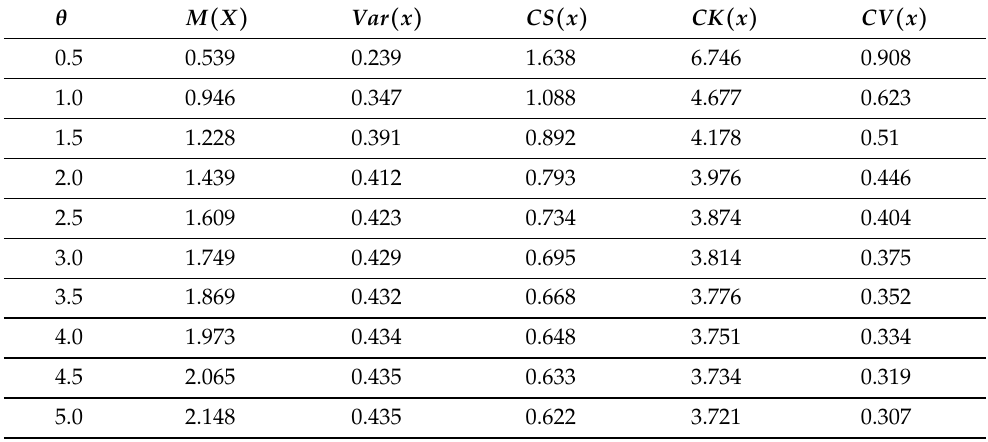
Table 2. Numerical values of M ( X ) , Var ( x ) , CS ( x ) , CK ( x ) , and CV ( x ) at β = α = 0.5 for the SBXL model.